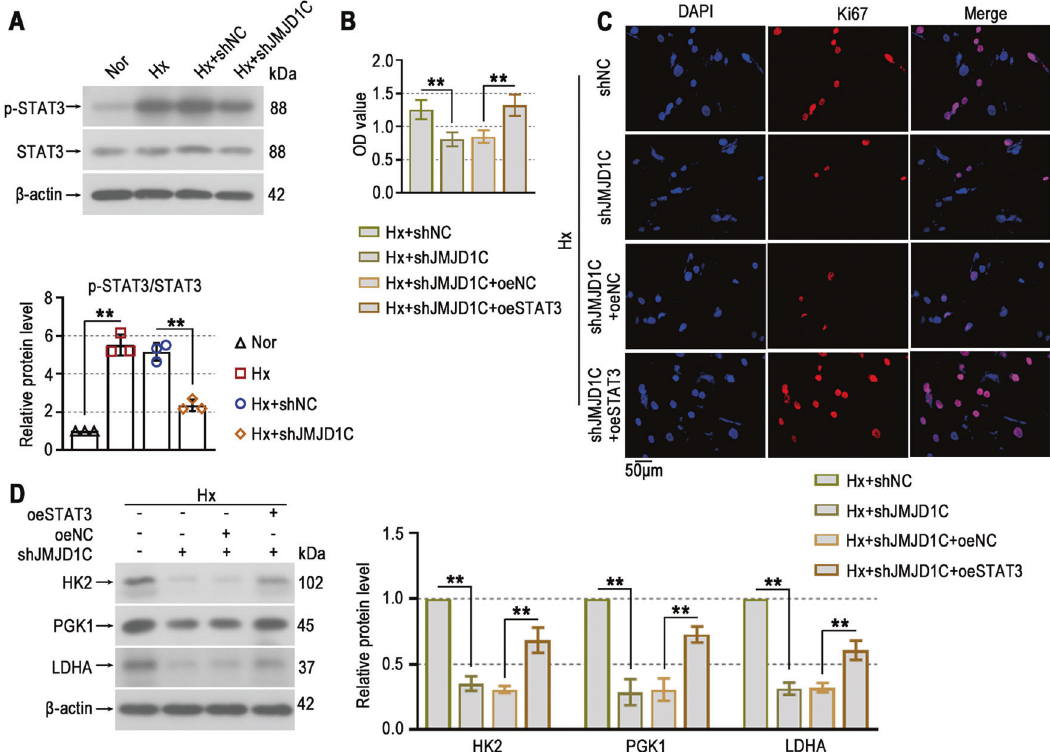
Fig. 7 STAT3 signaling activation is regulated by JMJD1C and stimulates PASMC proliferation and glycolysis. A Protein levels of p-STAT3 and STAT3 in PASMCs were determined by Western blotting. B The CCK8 assay was used to examine the survival of PASMCs. C Representative immuno fl uorescence images of PASMCs stained with anti-Ki67 antibodies (red). Cell nuclei were stained with DAPI (blue). Bar = 50 μ m. D Western blotting was performed to detect the protein levels of HK2, PGK1, and LDHA in PASMCs. Nor Normoxia, Hx Hypoxia. The values are the mean ± SD, and statistical signi fi cance was determined by one-way ANOVA. N = 3, ** p < 0.01.